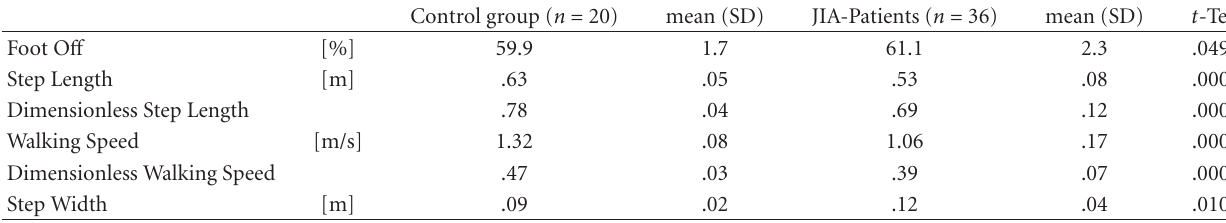
Table 1: Results of spatio-temporal parameters ( ∗ = statistically